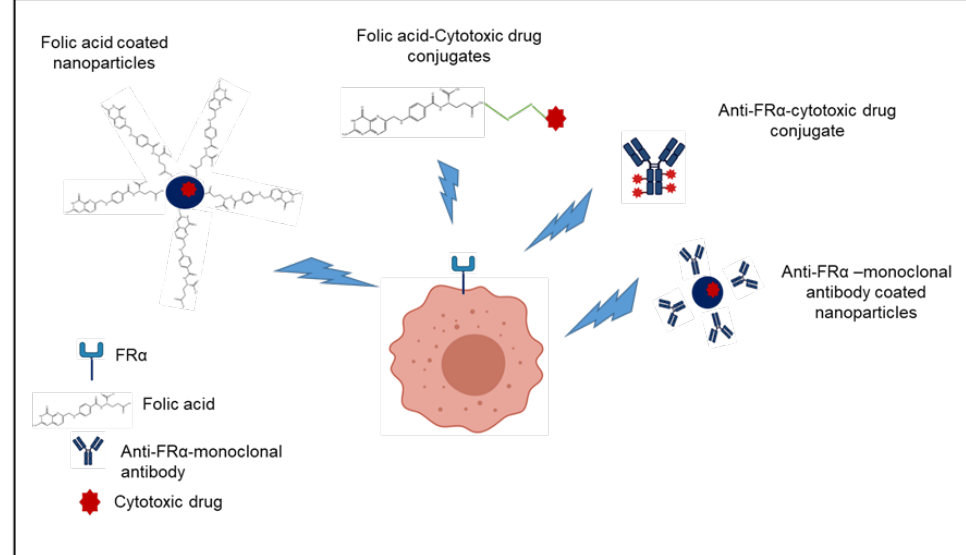
Figure 4. Summary of FR-targeted nanoformulations developed for cancer therapy.